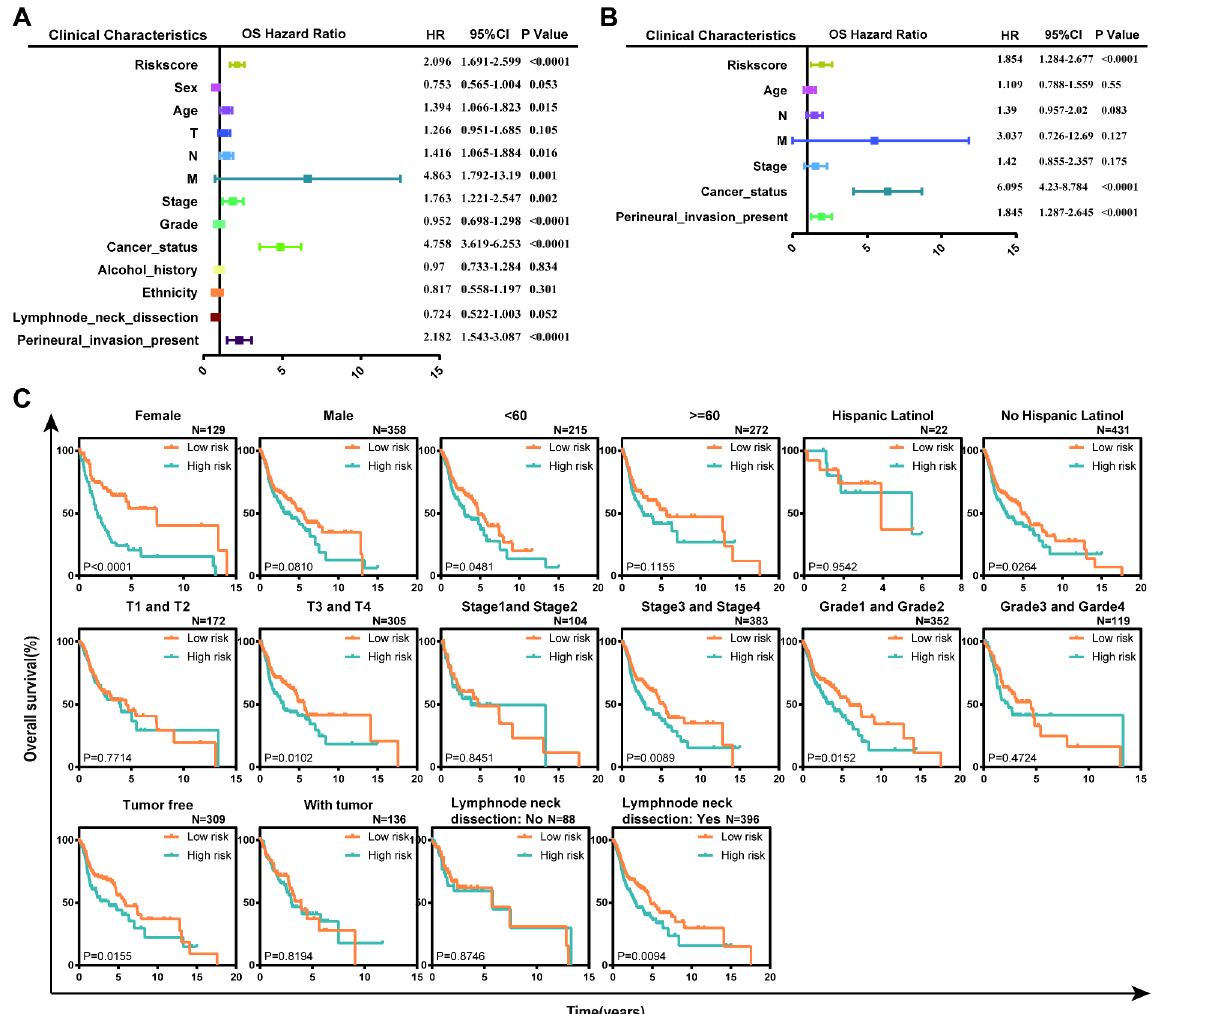
Fig. 5 Validation of the ERS-related prognostic signature in GEO dataset. ( A ) Kaplan–Meier curves of OS of low- and high- risk groups stratified by the risk scores in HNSCC in GEO dataset. ( C ) The distributions of risk scores and patient survival status for HNSCC in TCGA dataset. ( D ) ROC curve for the 5-year OS prediction by the ERS-related signature in GEO